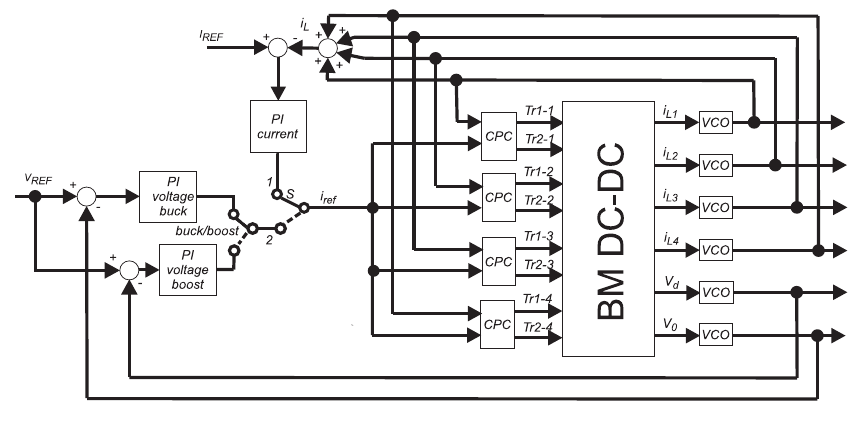
Figure 2. Four-leg bidirectional DC–DC converter scheme.